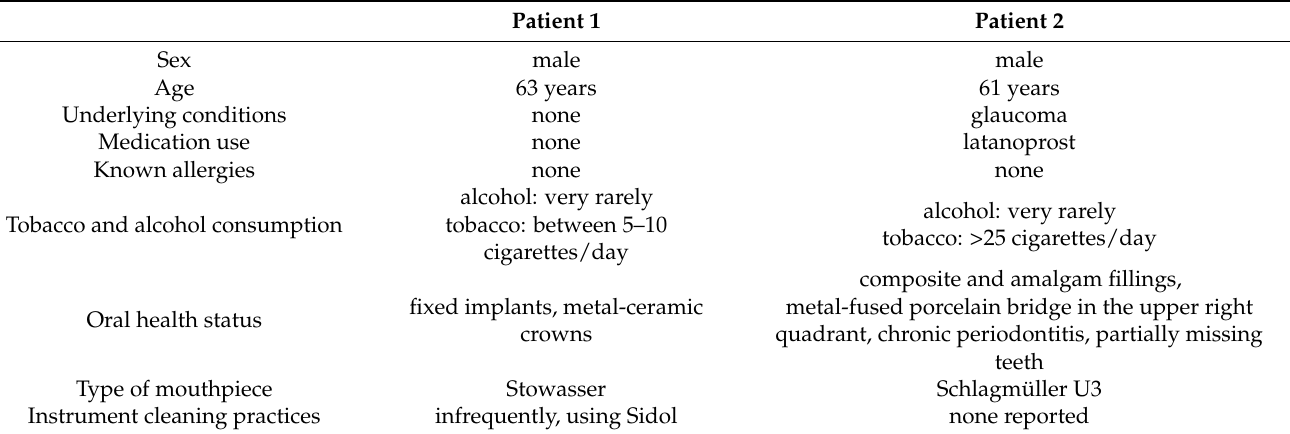
Table 1. Summary of patient